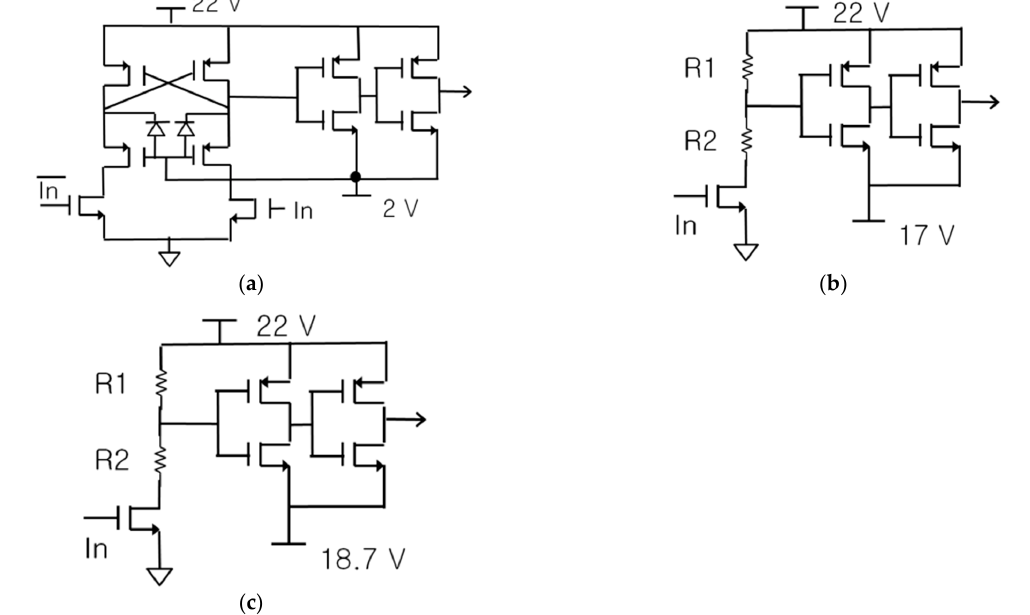
Figure 3. Schematic of high-side gate driver: ( a ) thick gate oxide, ( b ) mid gate oxide, ( c ) thin gate oxide.